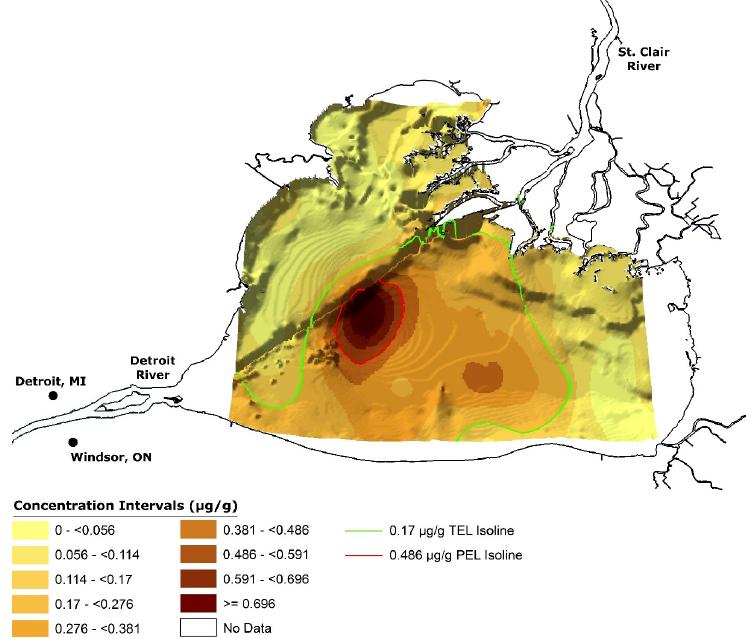
Figure 6. Three ‐ dimensional interpolated kriging distribution map for 2001.